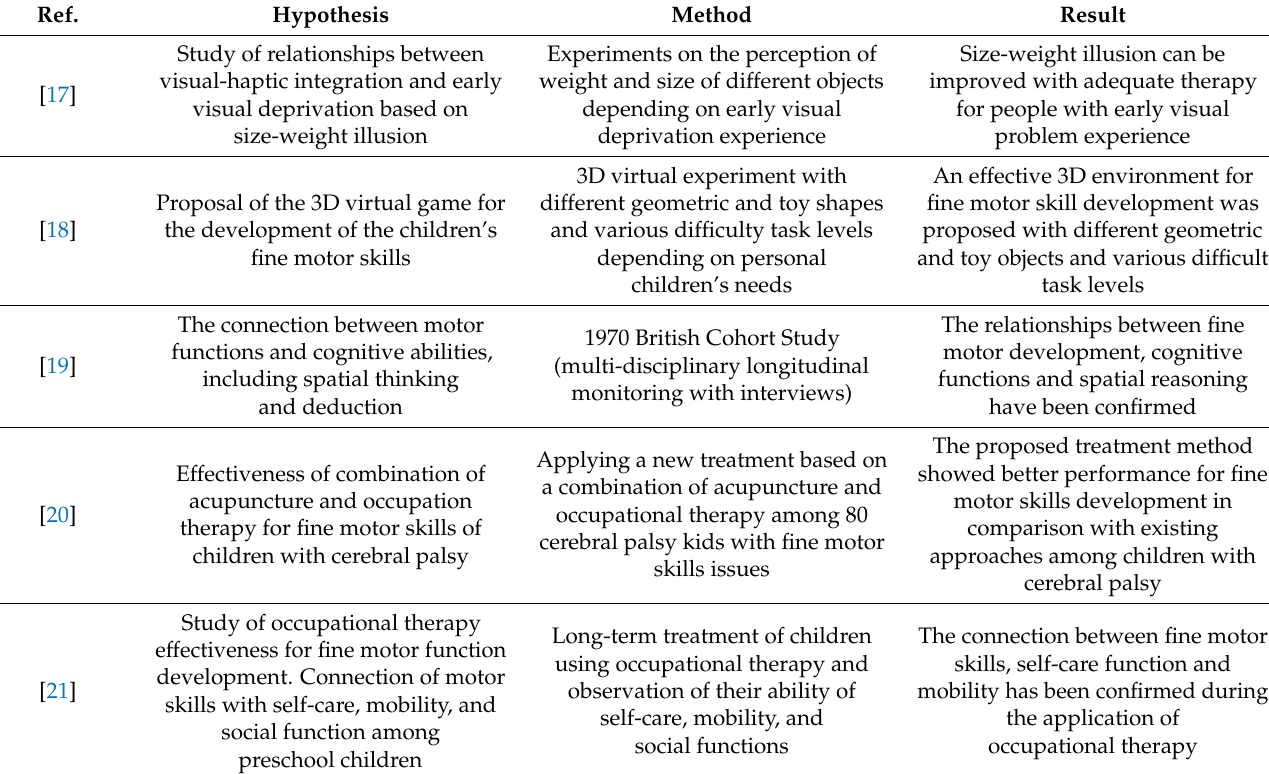
Table 1. Previous research